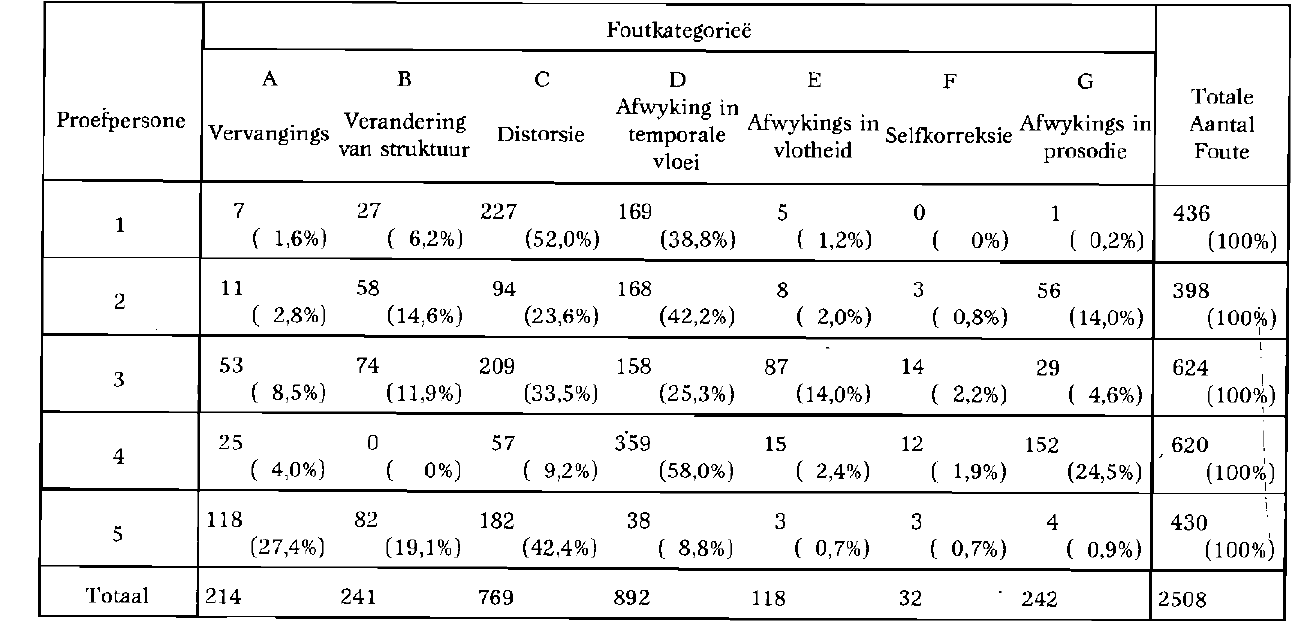
Tabel 3: Rangskikking van foutkategoriee in dalende volgorde van voorkoms by elke proefpersoon -Proefpersone Rangskikking van